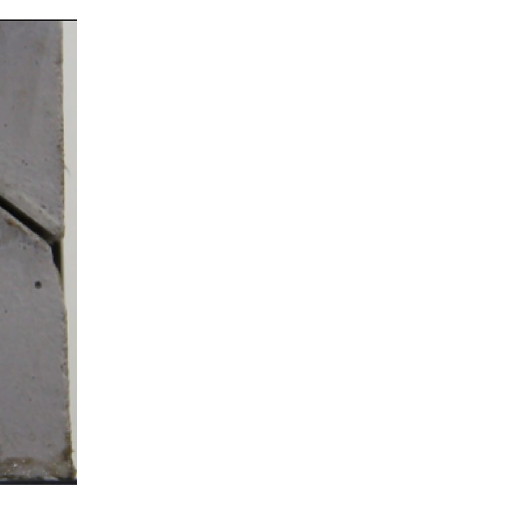
Figure 2. Finished sample before